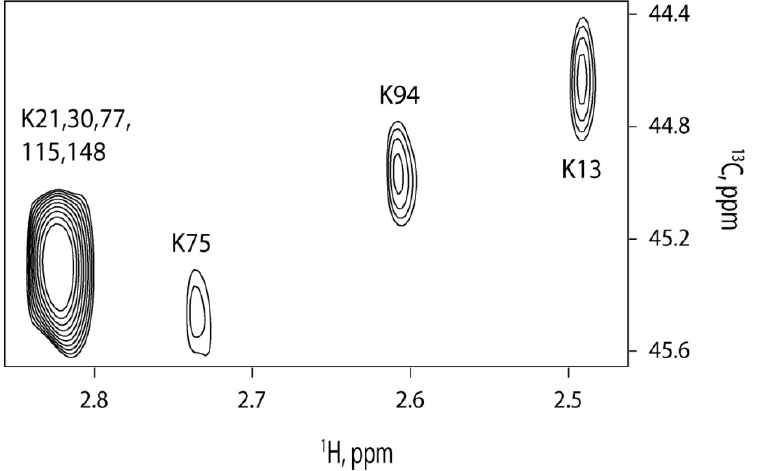
Figure 4. NMR spectrum of 650 nM reductively methylated